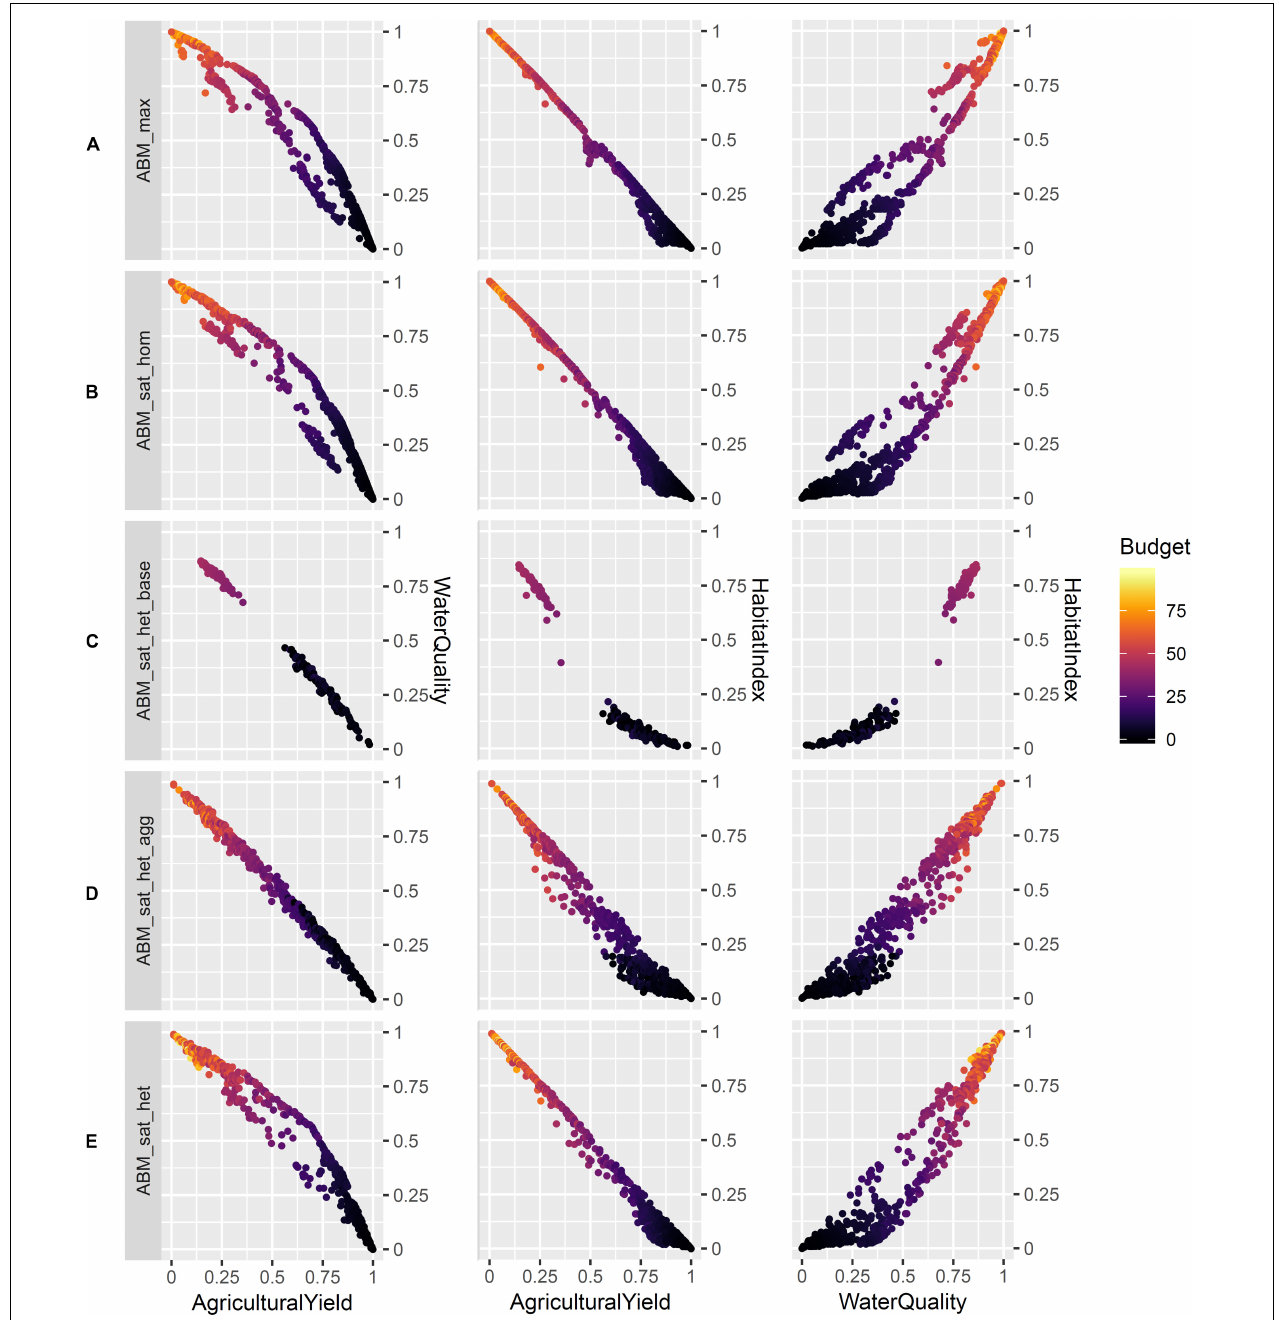
FIGURE 7 | Non-dominated solutions of ABM simulations colored by normalized total budget for agri-environmental payments in equilibrium. Note that the 3D solution space is shown in three 2D scatterplots. (A) ABM, maximizer variant; (B) ABM, satisficer variant, homogeneous income thresholds; (C) ABM, satisficer variant, heterogeneous income thresholds, base payment only; (D) ABM, satisficer variant, heterogeneous income thesholds, base payment and aggregation bonus; (E) ABM, satisficer variant, heterogeneous income thesholds, all